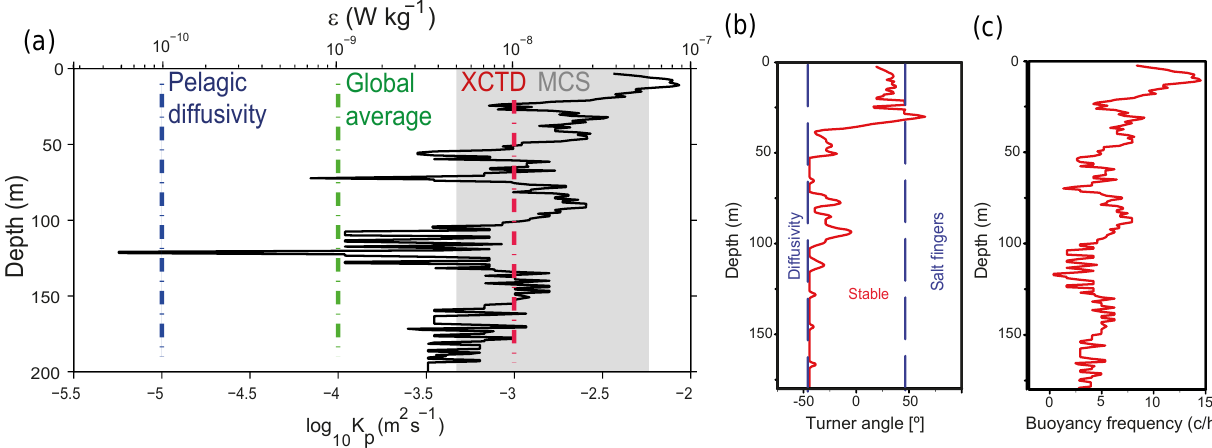
Figure 4. (a) Depth profile of ε(z) and k ρ (z) obtained from XCTD and ADCP data and applying the Gregg89 model. The blue dotted line is the pelagic diffusivity in the ocean ( k ρ ≈ 10 − 5 m 2 s − 1 ) , the green dotted line is the global average for overturning ( k ρ ≈ 10 − 4 m 2 s − 1 ) , the red dotted line is the average vertical profile from XCTD and ADCP data ( k ρ ≈ 10 − 3 . 0 m 2 s − 1 ) , and the gray area is the incidence range from MCS data ( k ρ ≈ 10 − 2 . 7 m 2 s − 1 ) . (b) Turner angle showing ranges; the blue dotted lines show where the water column is unstable to diffusivity (Tu< − 45 ◦ ) and stability ( − 45 ◦ <Tu<45 ◦ ) and prone to salt fingering (Tu>45 ◦ ). (c) Buoyancy profile calculated with the XCTD data.